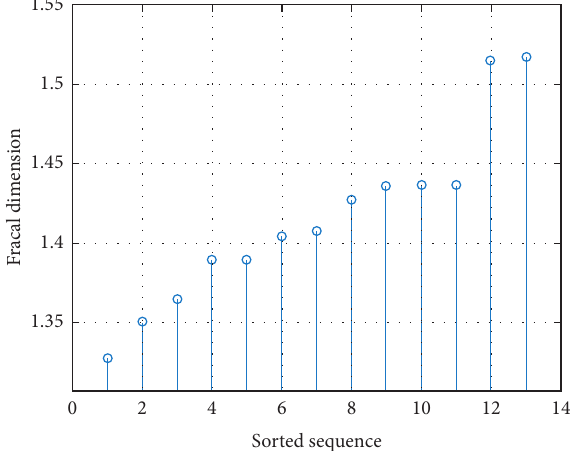
Figure 6: Fractal dimension of each ICA output